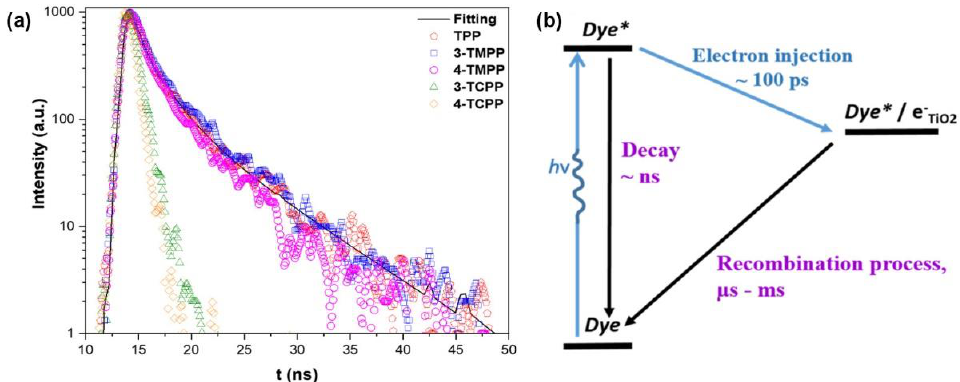
Figure 10. ( a ) Time-resolved emission decay of free-base porphyrins fitted with lifetime distribution fitting function and ( b ) diagram of the electron transfer mechanism, showing the competitive electron transfer that occurs in the DSSC photoanode. TPP = tetraphenylporphyrin; 3-TMPP = (3-tetra(methylphenyl)porphyrin; 4-TMPP = (4-tetra(methylphenyl)porphyrin; 3-TCPP = (3-tetra(carboxylphenyl)porphyrin; 4-TCPP = (4-tetra(carboxylphenyl)porphyrin. Adapted from reference [65] with permission from Wiley, copyright 2020.